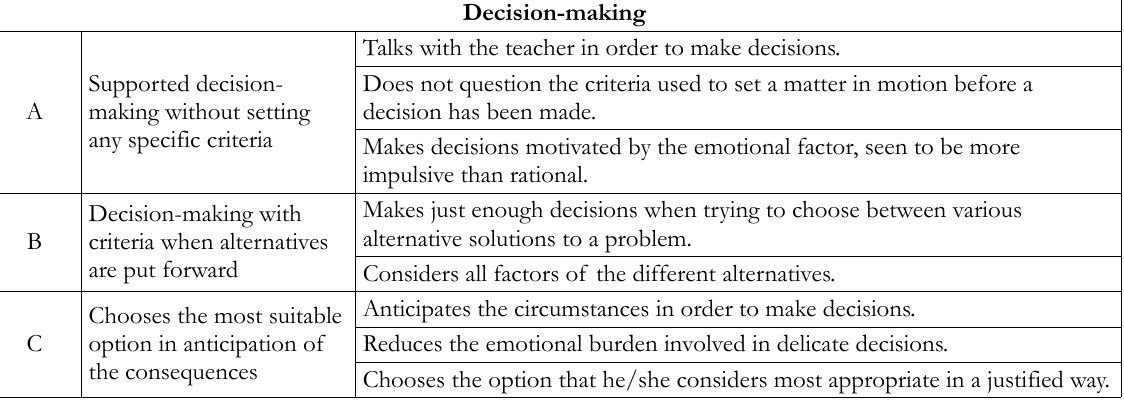
Table 1. Competency indicators for employability in accordance with command